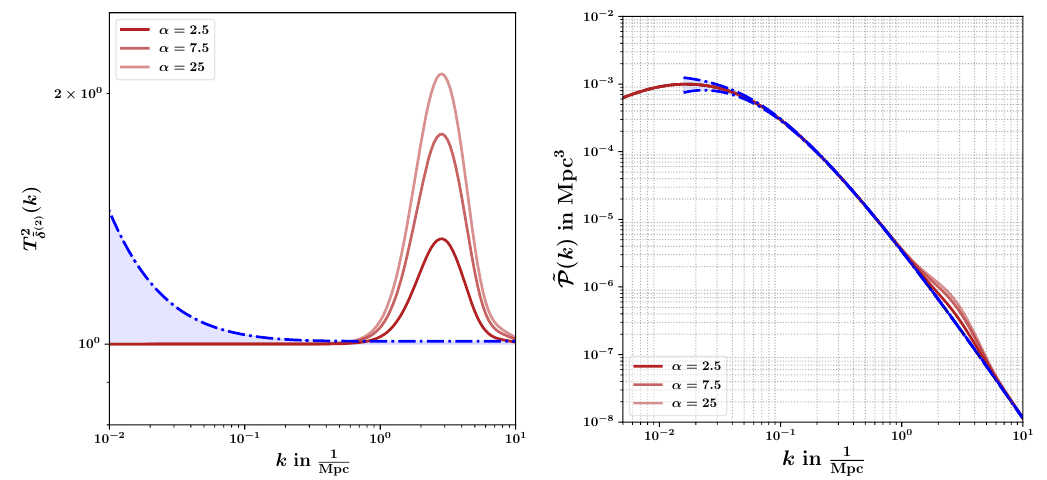
Figure 10: The impact of a late phase transition for different strength α on the linear matter power spectrum. We chose for each α an inverse duration of β = 3 H ∗ and fixed the transition time to t ∗ = 5 × 10 9 s, respectively.